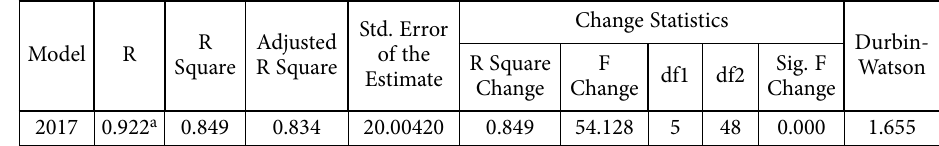
Table 7. Seasonal sustainability function for 2017